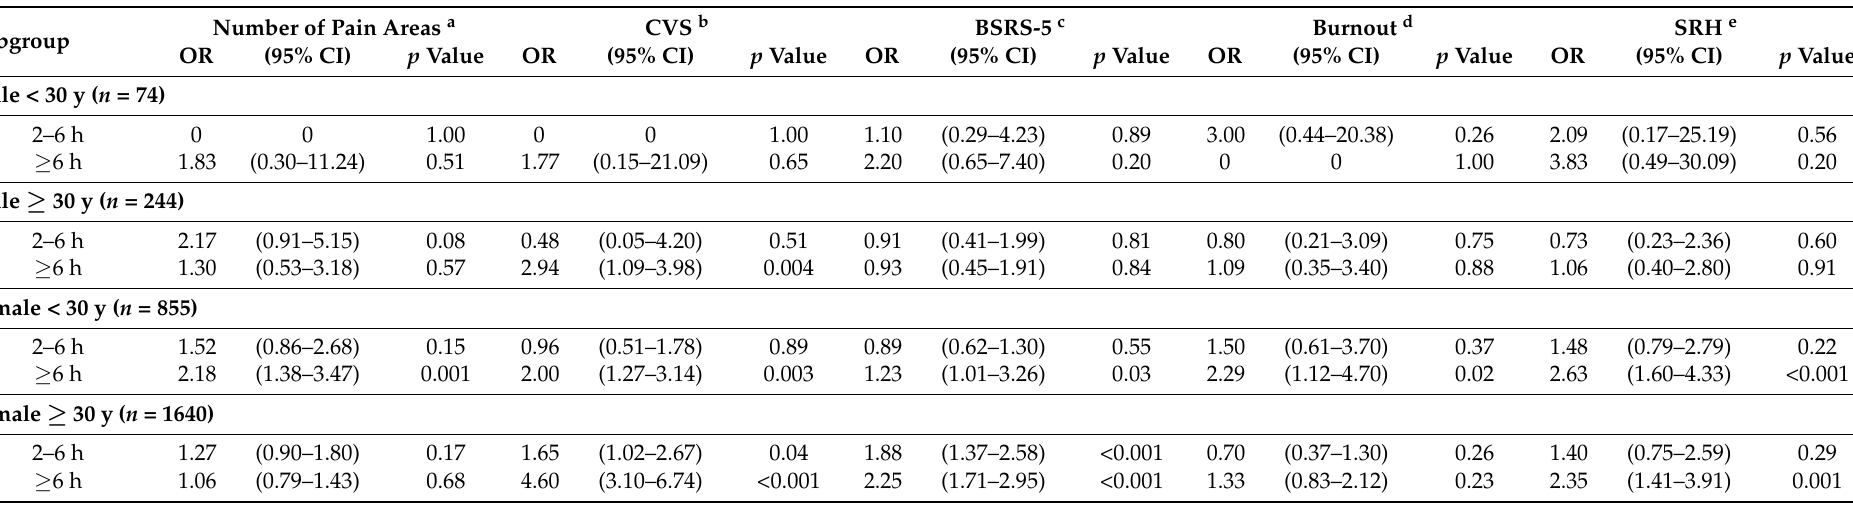
Table 4. Adjusted odds ratio (aOR) and 95% CI of the musculoskeletal system, visual system, mental health condition, and self-rated health status according to different durations of daily VDT working time using logistic regression analysis stratified by age and